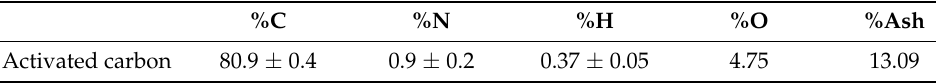
Table 2. Ultimate analysis of commercial activated carbon.